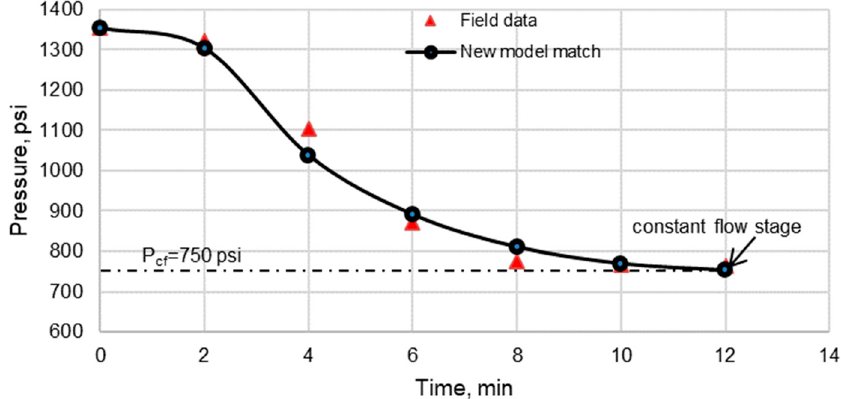
Figure 8. The mathematical model of SCP is matched to the bleed dowwn field data by iterating on initial gas chamber volume.